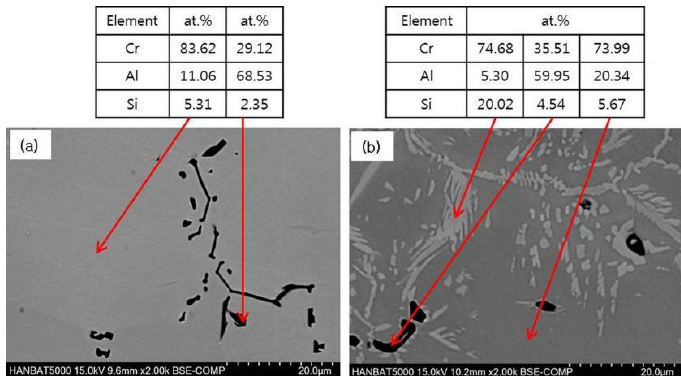
Figure 2. SEM-EDS analyses of as-cast Cr–xAl–5%Si alloys (2000X): ( a ) 10%Al; ( b ) 20%Al.